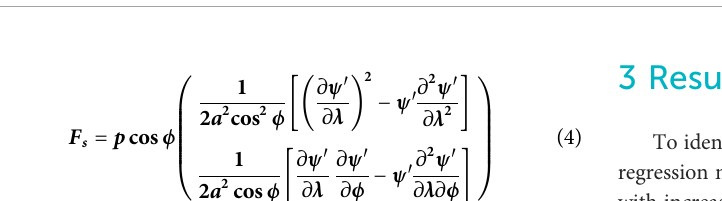
FIGURE 3 Regression maps of CK (shaded at 95% con fi dence level; m 2 s – 3 ) and (cid:1) u (contour; 30 m s – 1 ) at 250 hPa in each month from (A – E) January to May. (F,G) RegressionsofCK(shadedin F ;m 2 s – 3 ), − u ’ 2 z (cid:1) u z x (contourin F ;m 2 s – 3 ), (cid:1) u (shadedin G ;m s – 1 ),and z (cid:1) u z x (contourin G ;s – 1 ),whicharemeridionallyaveraged over 40 ° S – 20 ° S at 250